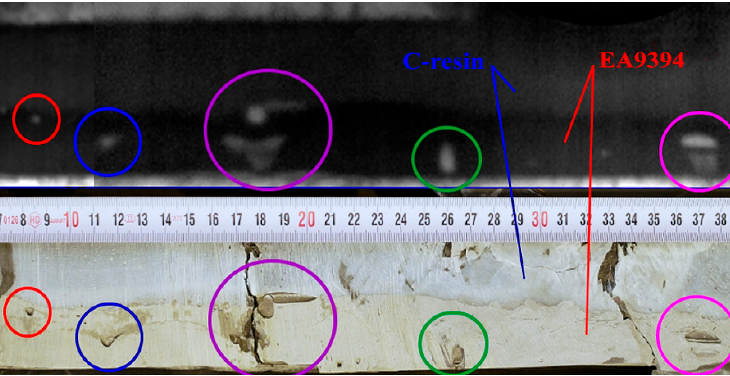
Figure 19. Comparison of NDE findings ( top ) with the actual condition of the adhesive joint ( bot- tom ).